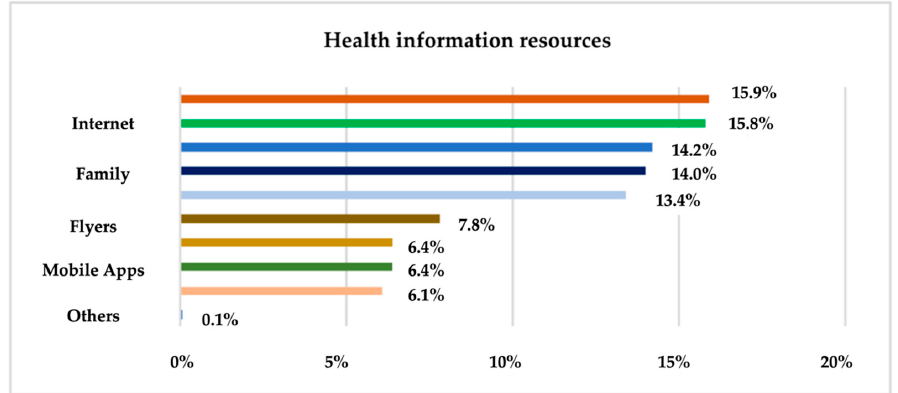
Figure 3. The sources used for health information.